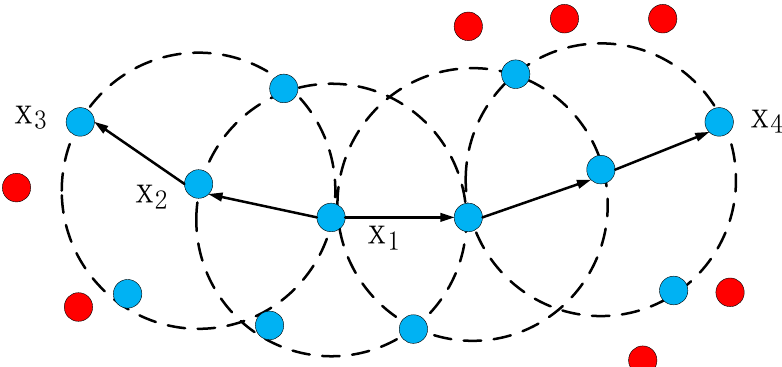
Figure 4. The above figure visually shows these concepts in DBSCAN: When MinPts = 3, the dotted circle is the e neighborhood, X 1 is the core object, X 2 is directly connected by X 1 density, X 3 is reachable by X 1 density, and X 3 is connected with X 4 density.